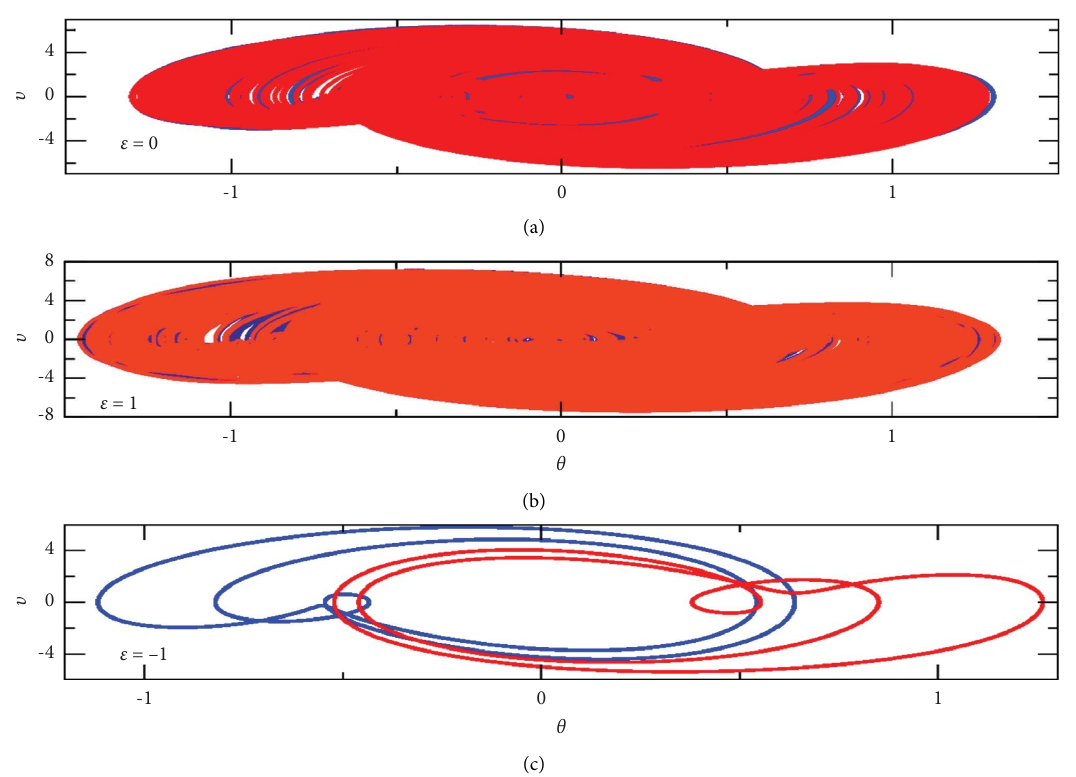
Figure 14: Phase portraits showing a coexistence of attractors for ϵ � 0 ; ± 1 ; F � 45 . 6 ; α � 10 ; β � 1 ; Ω � 2 ; C 0 . 1 ; K � 0 . 1 ; g � 10 ; U � 2 . 5. Blue phase portrait corresponds to the initial conditions ( 1 ; − 1 ) , while the red phase portrait corresponds to the initial conditions ( 1 ; 1 . 5 )